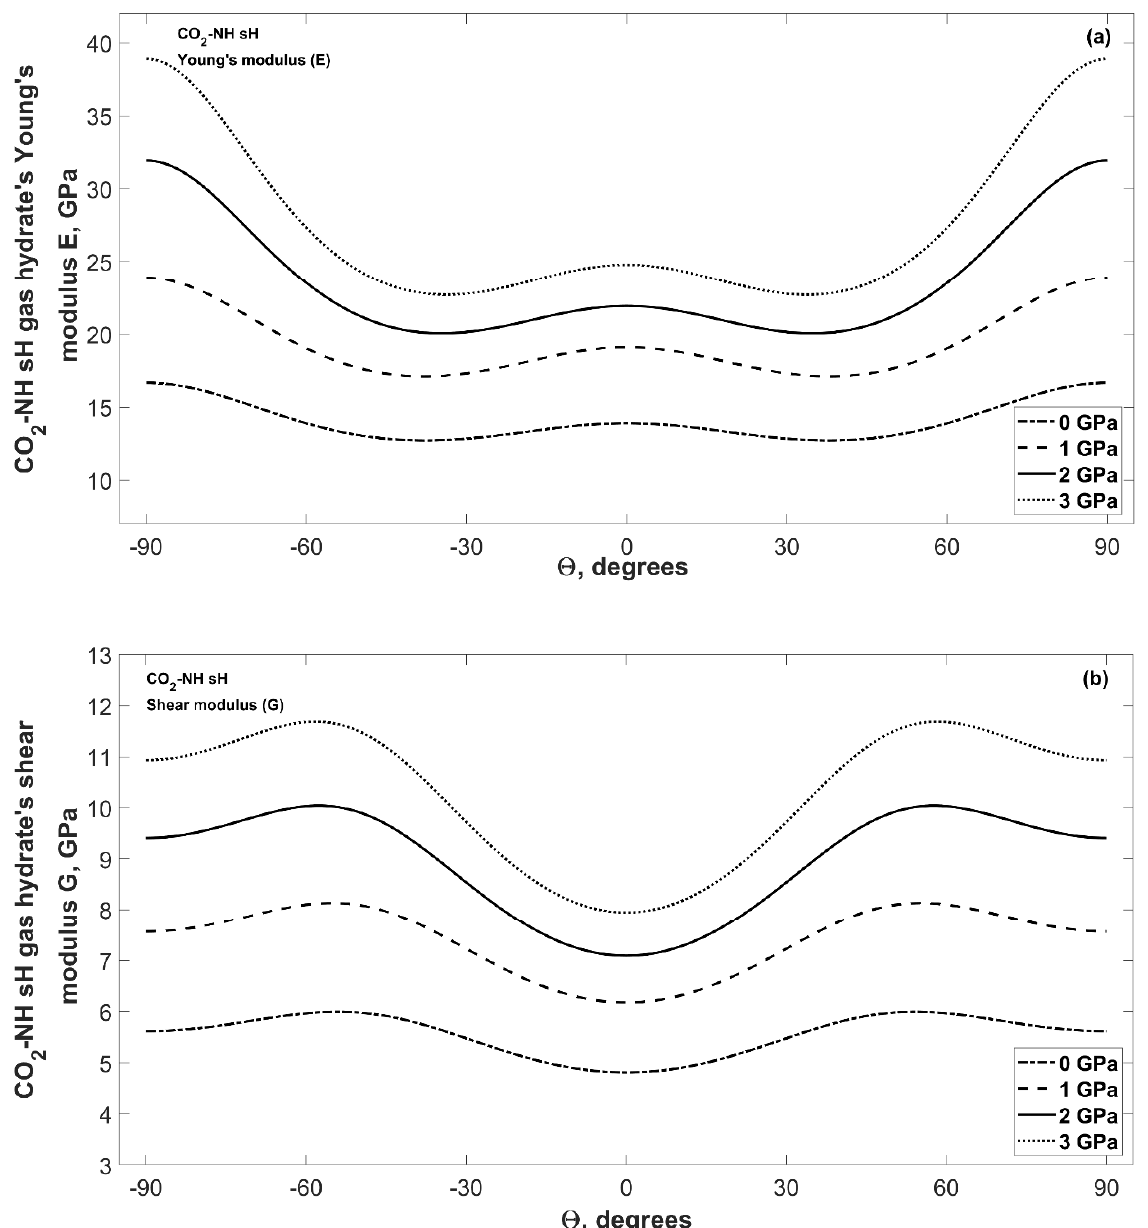
Figure 9. Direction-dependent Young’s E ( a ) and shear G ( b ) moduli of CO 2 -NH sH gas hydrate at different pressures and 0 K.